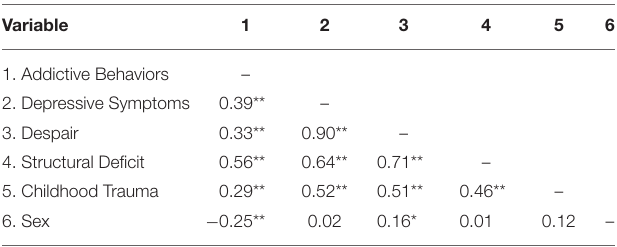
TABLE 2 | Correlations among latent variables and sex for the measurement model.